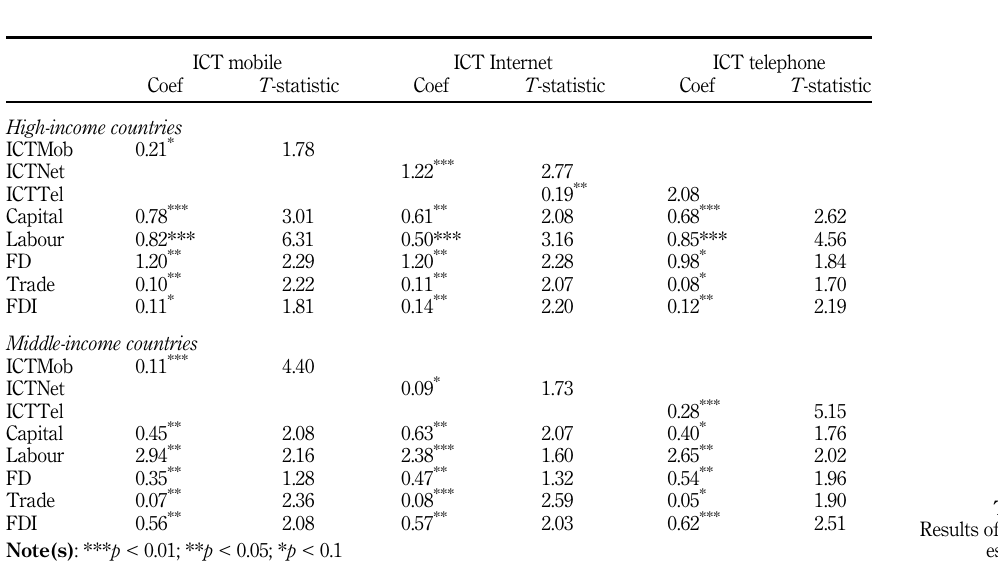
Table 8. Results of cross- sectional dependence tests